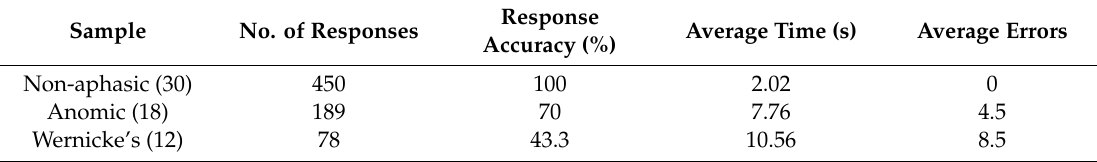
Table 3. Performance analysis summary of repetition